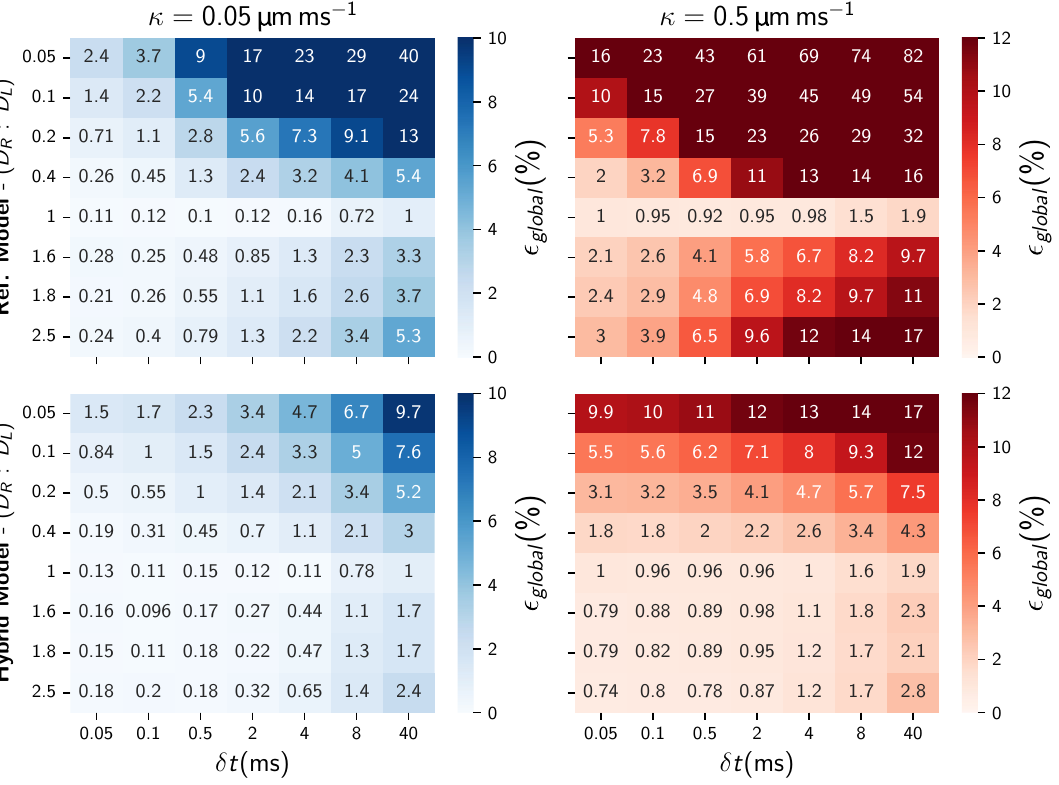
Figure 5. Global errors using the reference (upper row) and hybrid transit model (lower row) for different time D R and two different permeabilities κ . The global error measures the steps δ t , distinct diffusivity ratios D L : accuracy of the numerical simulation by calculating the area between the analytical and numerical cumulative 10 6 walkers seeding the 1000 ms with N flux during the entire simulation. Simulations were run until t p = = 6, 14 µ m walkers in a partial uniform region in the left compartment x 0 ∈ [ ] errors for the reference model and hybrid model respectively. As mentioned in “Transient and steady state analy- sis of diffusion flux in a two compartment domain”, each simulation has been performed initialising the walkers in a partial uniform region within the left compartment. For a constant permeability, we observe that the global errors escalate as we increase the difference between diffusivities. These increments are consistently lower for the hybrid model as it includes the probability when transitioning between two different media through Eq. (6). Similarly to Fig. 4, lowering the step size increases the number of walker collisions with the membrane resulting in an overall faster convergence and accuracy. As it can be observed in Eq. (6), the hybrid model incorporates the reference model to solve the membrane/interface probability. In Appendix C, we show that the reference model does not preserve the interface reflection and leads to a permeability-related error. As a result, both models show a permeability error dependency, however, the hybrid model relative errors are consistently lower due to the initial error reduction in the diffusion media. The dependencies of the accuracy ( ǫ global ) on the time step ( δ t ) shows that the improvement in simulation efficiency provided by the hybrid model is greatest for highly D L 0.05 , 0.5 µ m / ms and (i) D R permeable membranes and large diffusivity gradients. As an example, for κ : = = D L 2.5 similar accuracies (i) ǫ global 40ms and 16% and (ii) ǫ global 2.8% are obtained with δ t (ii) D R : = = ≈ ≈ δ t 0.05 ms using the reference and hybrid model respectively. As a consequence, for a similar accuracy the = 950 s to 5s . For the low permeability case hybrid model reduces the simulation time by a factor of 190 from ≈ ≈ κ D L 0.05 accuracies of 3.5% are obtained with δ t 2ms 0.05 µ m / ms and highest diffusivity ratio D R : = ≈ = = 0.1ms . In this case the com- using the hybrid model while the reference model requires a lower time step δ t = putational time is a factor of 5 lower, which although reduced from 190, is still substantial.